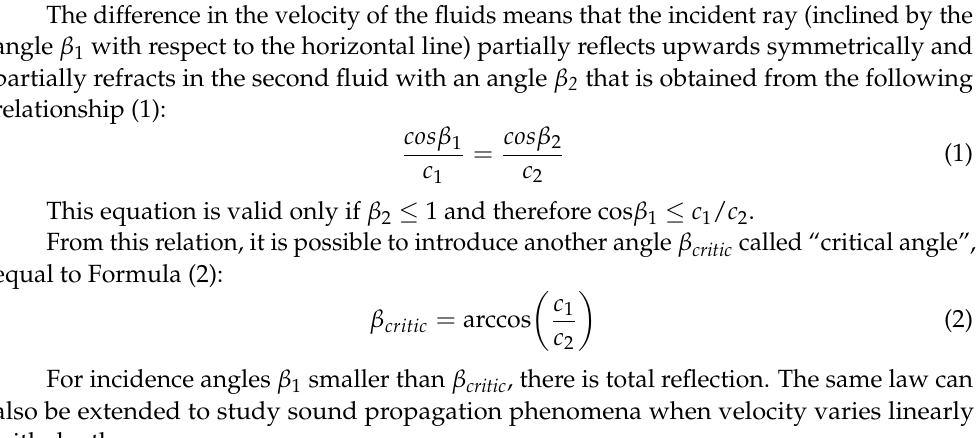
Figure 1. Incident ray which partly reflects and partly is transmitted in the second fluid. Snell–Descartes Theorem. The ratio of the cosines of the angles of incidence and refraction is equivalent to the ratio of phase velocities in the two media, or equivalent to the reciprocal of the ratio of the indices of refraction.